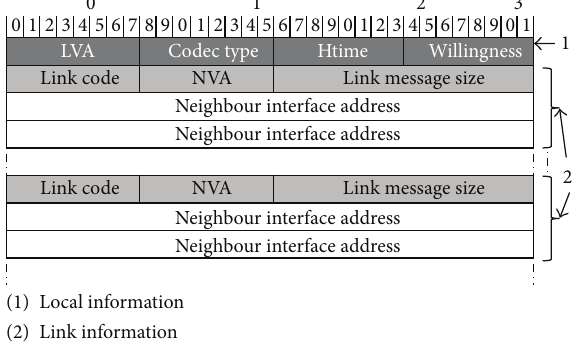
Figure 5: OLSR-VA HELLO